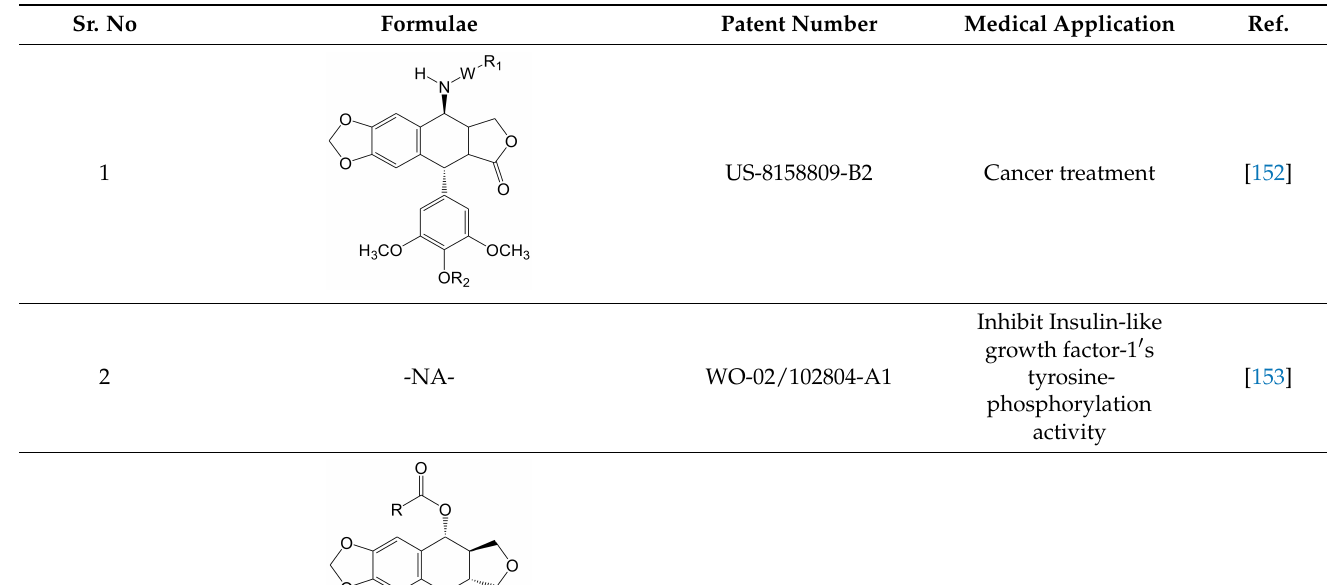
Table 5. Novel patented podophyllotoxin